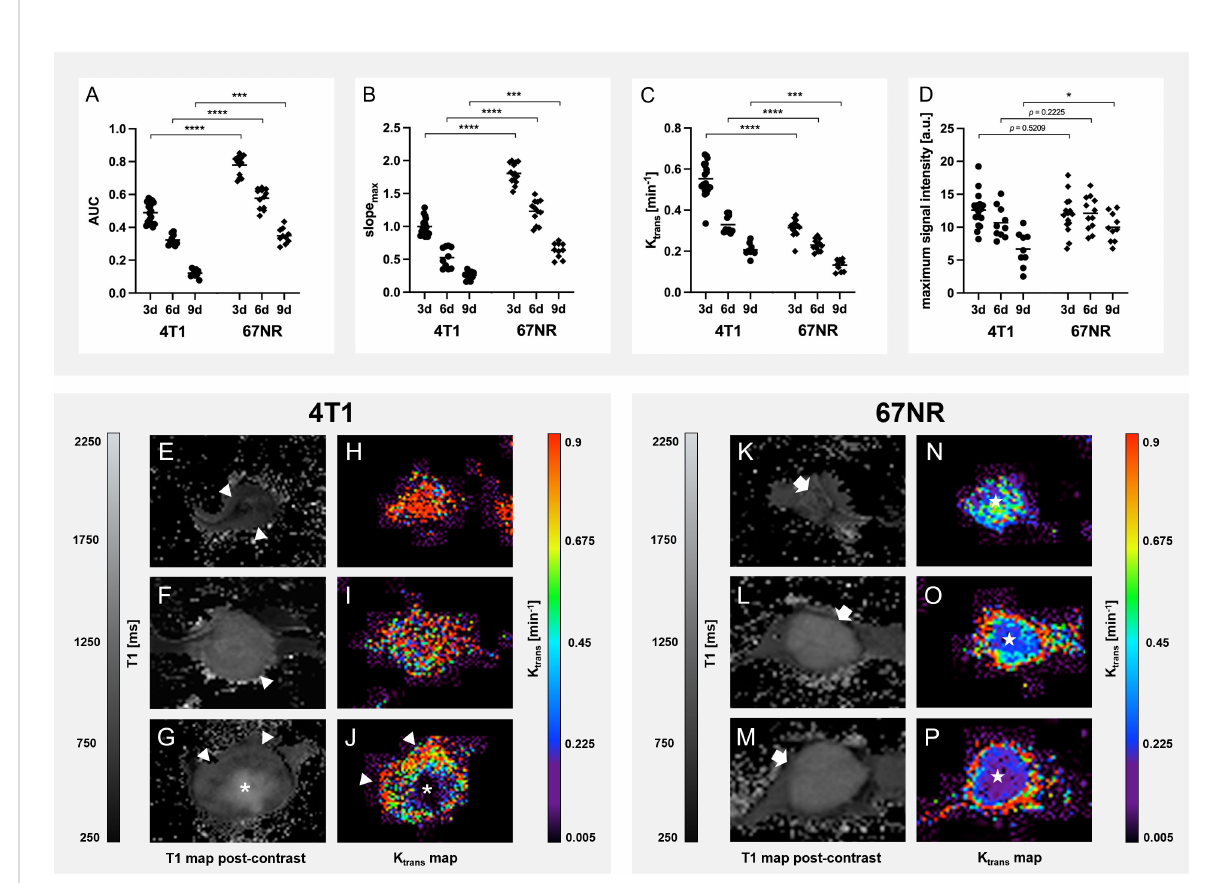
FIGURE 5 Detailed analysis of Dynamic Contrast-Enhanced imaging. Analysis of the DCE data with area under the curve (AUC, A ), maximum slope (slopemax, B ), Ktrans (C) and maximum signal intensity (D) show a higher permeability of 4T1 tumors than 67NR tumors, re fl ected in higher Ktrans values of 4T1 tumors, but with a greater in fl ow of the contrast agent in 67NR tumors, visible in AUC and slopemax, due to more intact blood vessels. Exemplary T1 and Ktrans maps of 4T1 tumors ( E – J , respectively) and 67NR tumors ( K – P , respectively) show heterogeneous areas of contrast agent retention with a viable periphery (arrowheads), and necrosis in the center (asterisks). All of the assessed parameters decreased over time, re fl ecting a reduced perfusion and permeability during progression for both tumor models. Mean values of the ROI covering the tumor in single slice imaging are shown. * p < 0.05, *** p < 0.001, **** p <